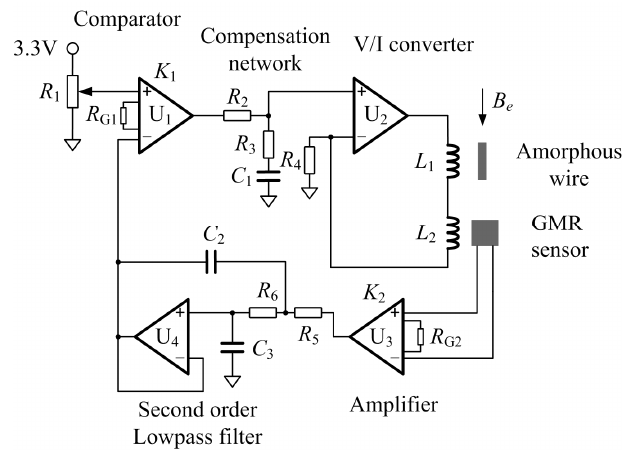
Figure 4. The structure of operating point self-regulator.